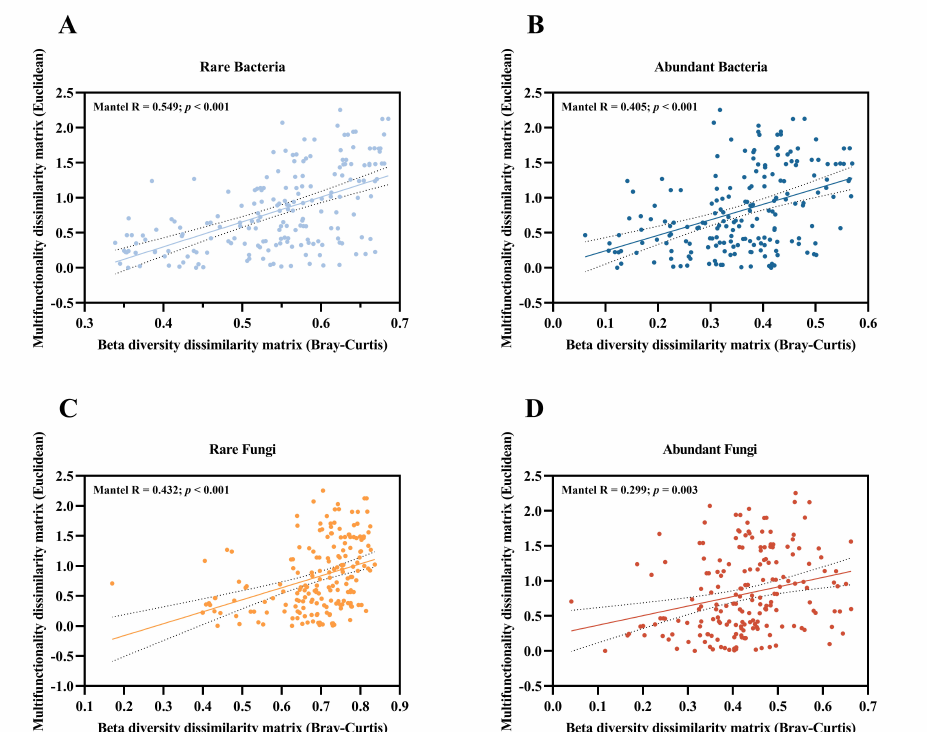
Figure 5. Mantel correlation between ecosystem multifunctionality dissimilarity and ( A ) rare and ( B ) abundant bacterial; and ( C ) rare and ( D ) abundant fungal community β -diversity dissimilari- ties. The solid lines represent significant linear regressions, and the dotted line represents the 95% confidence interval of the